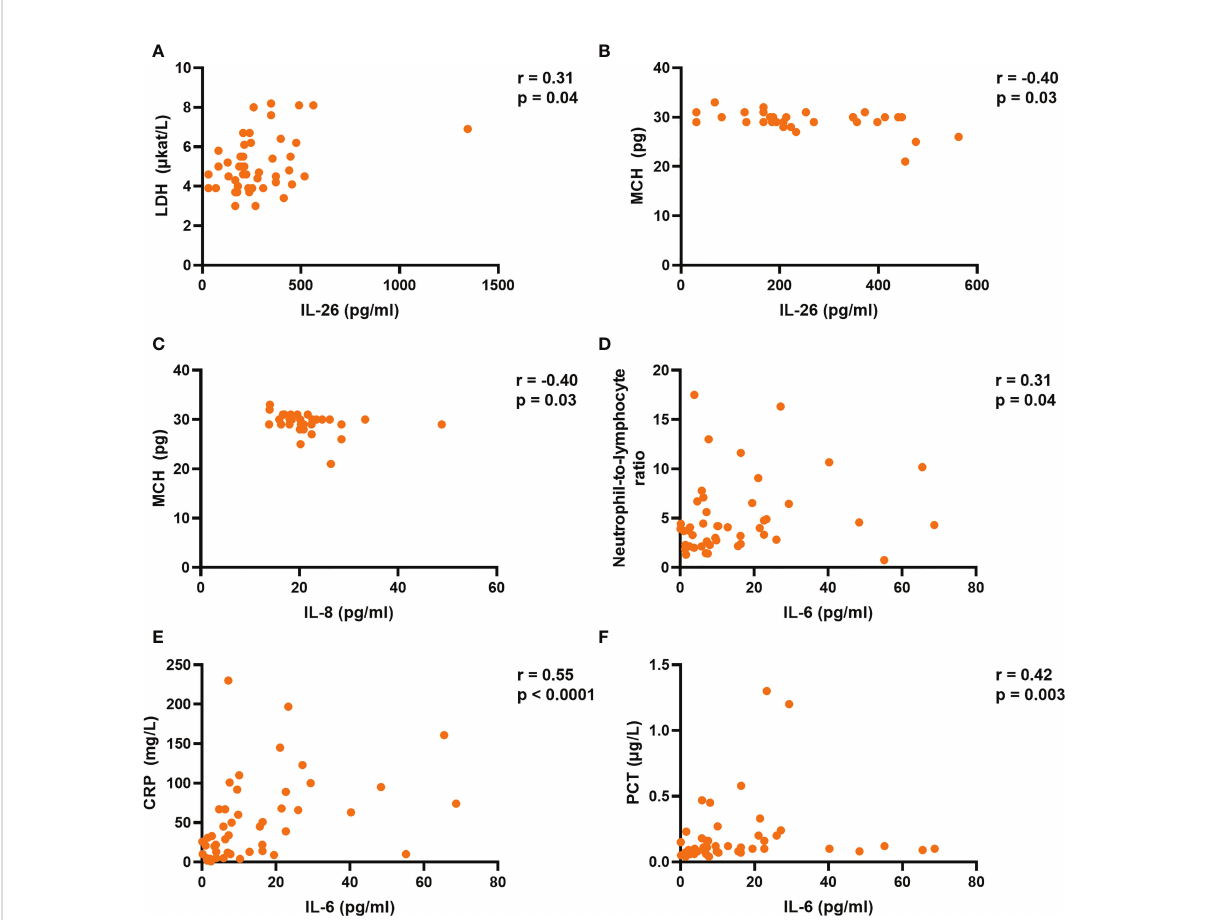
FIGURE 4 The plasma concentration of IL-26 is associated with those of lactate dehydrogenase (LDH) and mean corpuscular hemoglobin (MCH) in acute COVID-19. Spearman correlation analyses of the plasma concentrations of IL-6, IL-8, and IL-26 with those of (A) LDH, (B, C) MCH, (D) blood neutrophil-to-lymphocyte ratio, (E) C-reactive protein (CRP), and (F) procalcitonin (PCT) in the COVID-19